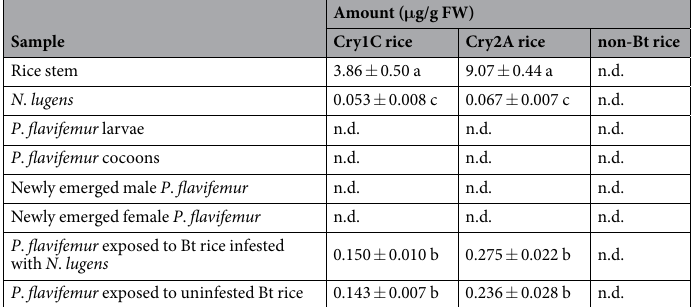
Table 2. Bt protein levels in Bt rice plants, Nilaparvata lugens and Pseudogonatopus flavifemur . Means ( ± SE) within a column followed by different letters are significantly different (One-way ANOVA, P < 0.05); N = 5. n.d. – not detectable. The detection limit for the two Cry proteins was 1 ng/g.